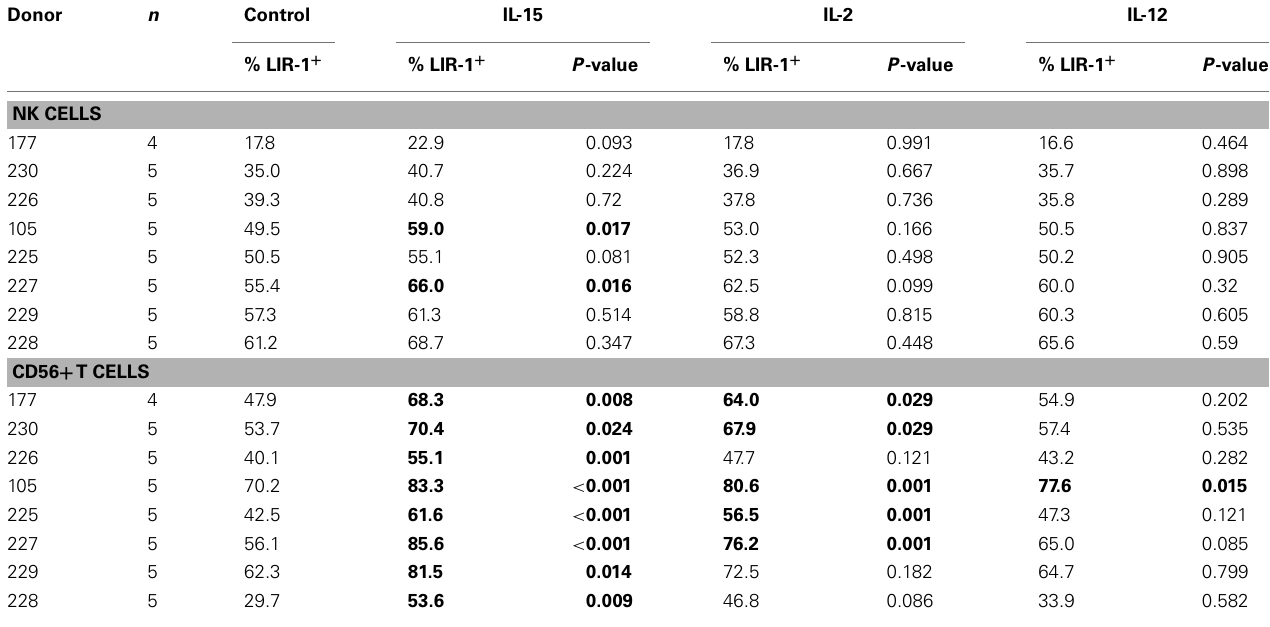
Table 1 |The effect of cytokine stimulation on cell surface LIR-1 expression in lymphocyte subsets isolated from various healthy donors and cultured for